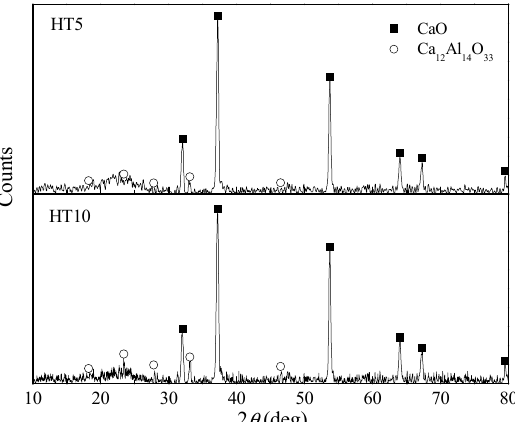
ff raction (XRD) pattern of synthetic sorbents HT5 and Figure 3. X-ray diffraction (XRD) pattern of synthetic sorbents HT5 and HT10. Figure 3. X-ray di